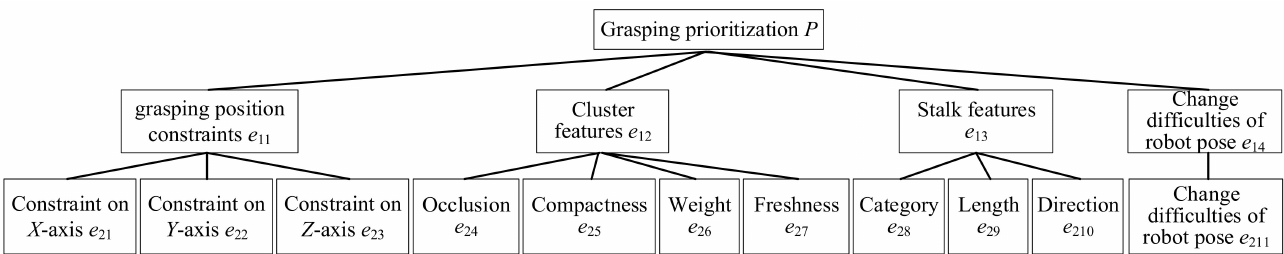
Figure 7. Prioritization model for grasping stacked fruit